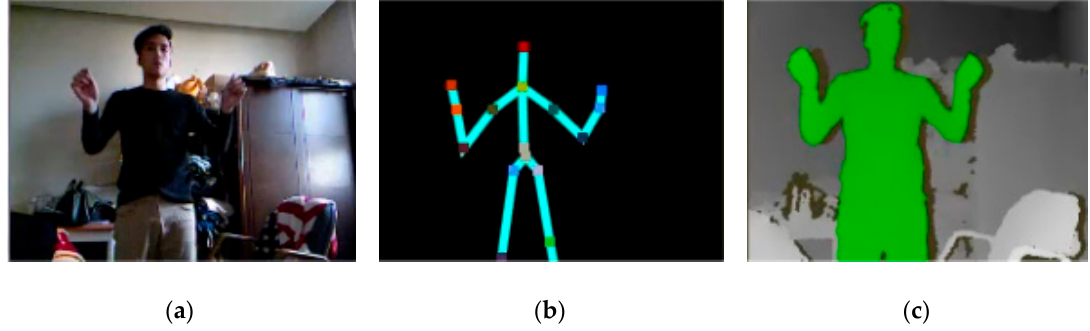
Figure 3. Three inputs for our proposed system: ( a ) original input, ( b ) skeleton image, and ( c ) depth image with the target body marked in green.